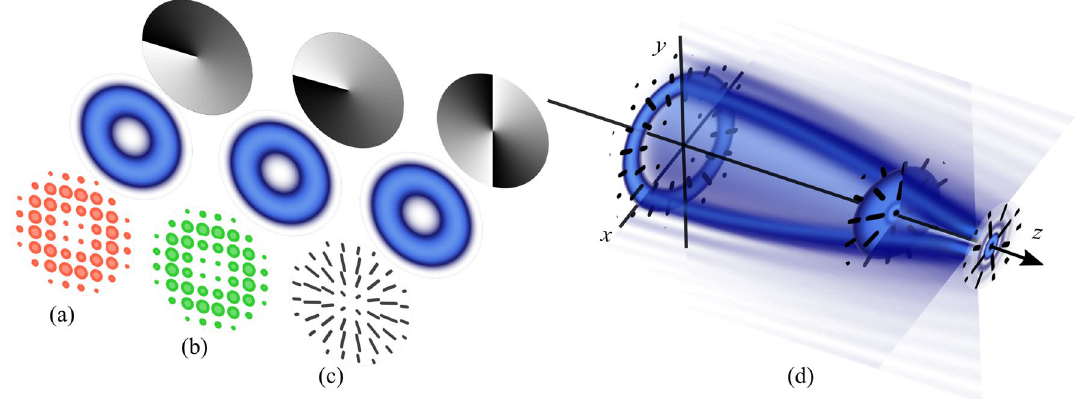
Figure 1. Polarization distribution (front panels), intensity profiles (middle panels) and transverse phase (back panels) of the modes ( a ) U 1 ˆ e R , ( b ) U − 1 ˆ e L and ( c ) (cid:31) 1, − 1 , respectively. In ( d ) we illustrate schematically the autofocusing effect such beams experience upon propagation. Here, orange and green ellipses represent right and left circular polarization, while black lines symbolize linear polarization. For this example, a = 1, w = 0.1, r 0 = 1, ν 1 = ν 2 = 0